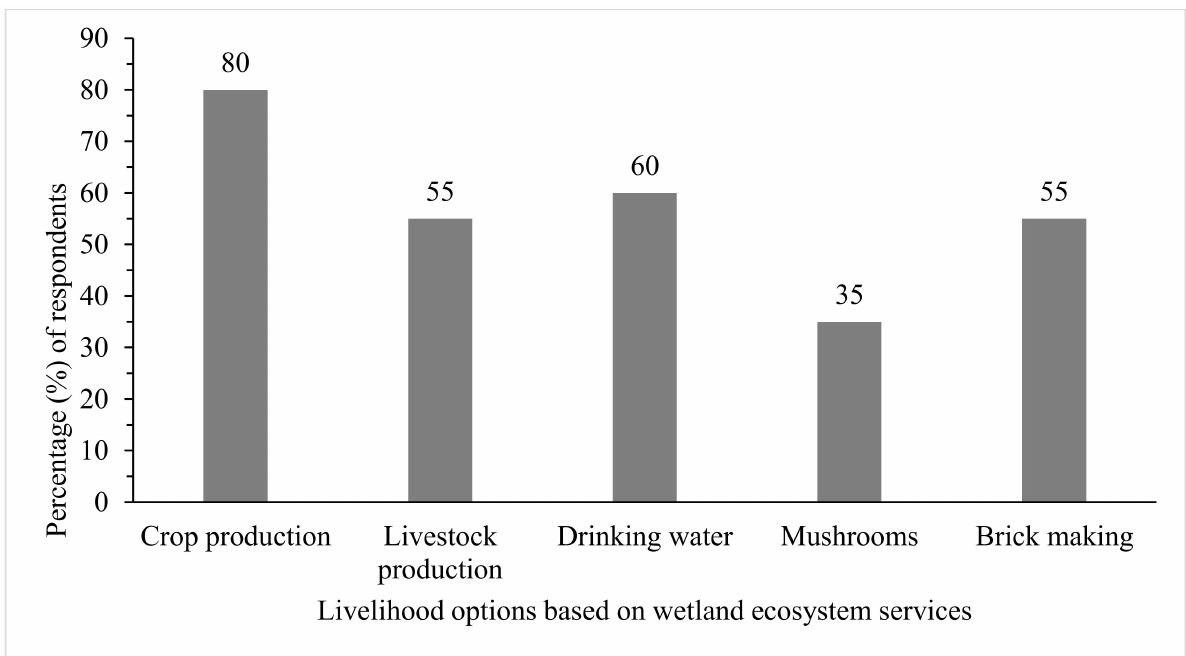
Figure 8. Household livelihood options based on the wetland